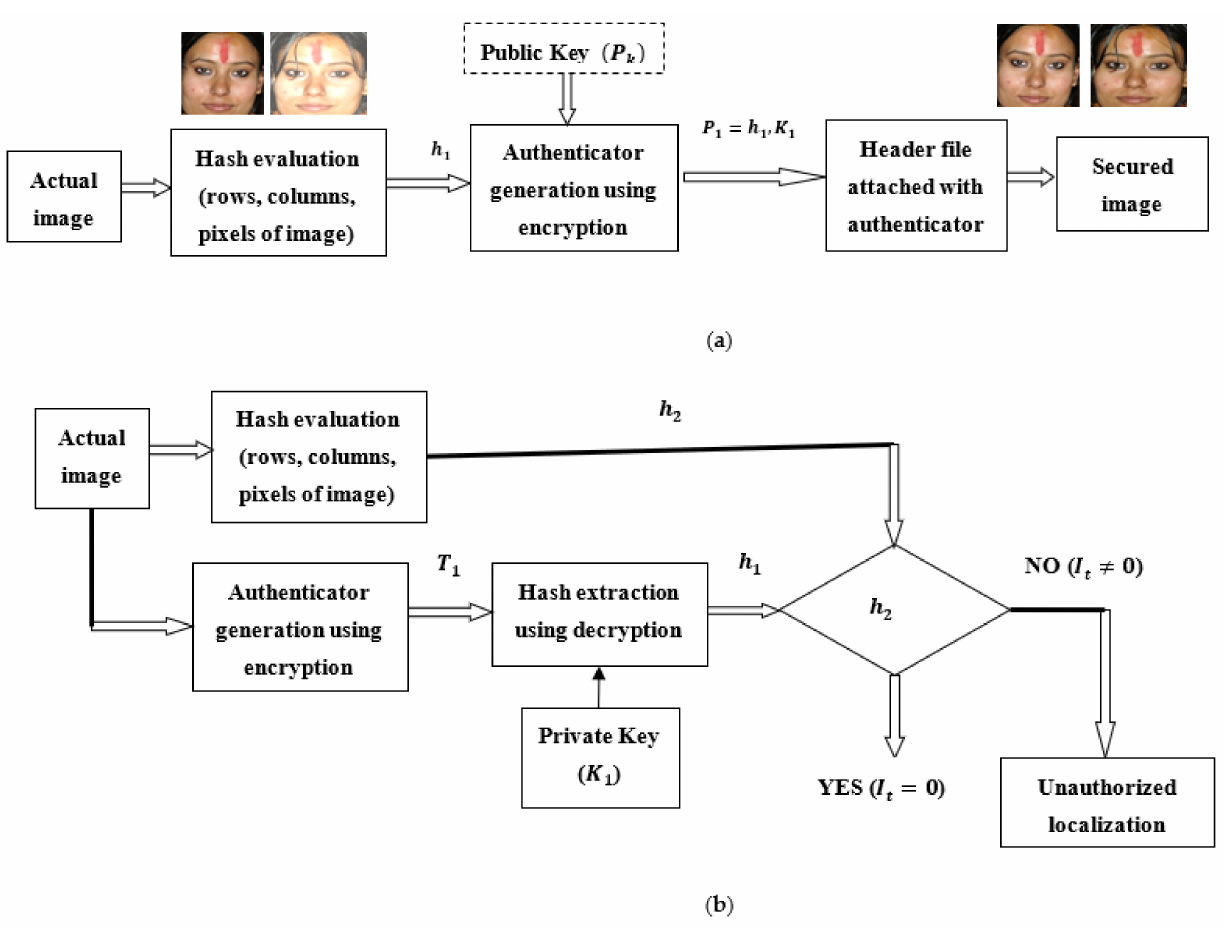
Figure 5. System for image authentication using cryptography following public & private key; ( a ) authenticator generator; ( b ) authenticity